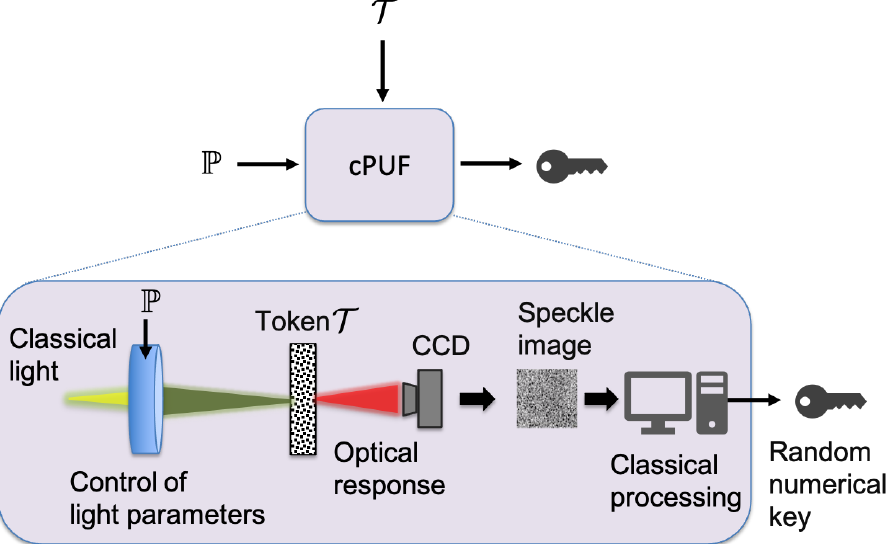
Figure 2. Schematic representation of a pseudorandom number generator based on optical PUFs with classical readout (cPUF). Classical light with parameters P is scattered from the disordered token T . The optical response is processed classically to yield a random numerical key. Typically, the classical processing also involves error correction so that to ensure the stability of the derived key in the presence of inevitable noise and imperfections. The depicted construction can be used for the generation of a random binary string, a random integer, or a short (4-digit) PIN, by processing accordingly the